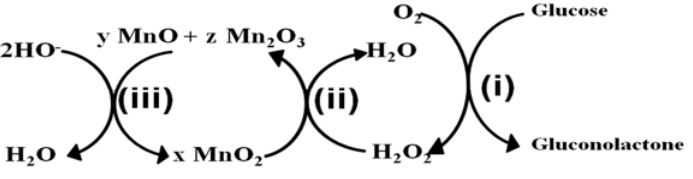
/GOx modified SPE based on 2 O (redrawn from reference 2 2